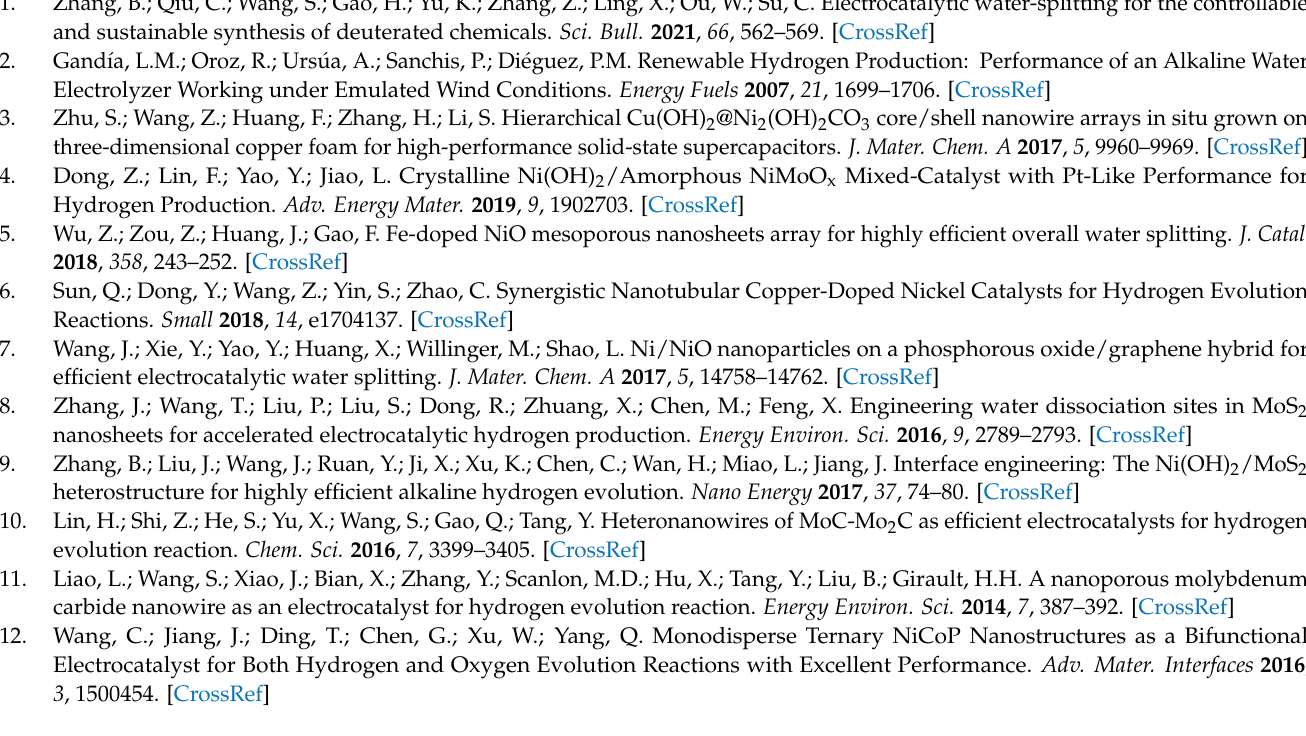
and the long-term stability measurements of Ni-Ni 3 C/NC-400, Ni-Ni 3 C/NC-450, Ni-Ni 3 C/NC-550 and Ni-Ni 3 C/NC-650 at 25 mA cm − 1 constant current density. Figure S13: (a, b) SEM micrograph, (c, d) TEM micrograph of Ni-Ni 3 C/NC-500 after a 100 h HER measurement. Figure S14: XPS spectra of Ni-Ni 3 C/NC-500 after a 10 h long-term HER test. Figure S15: Thermogravimetric analysis (TGA) curve of Ni-Ni 3 C/NC-500. Figure S16: The equipment picture of alkaline OWS test in 1 M KOH solution. Figure S17: The volumes of H 2 and O 2 as a function of time in the electrocatalytic overall water splitting. Figure S18: Side (top) and top (bottom) view of three surfaces, including Ni (111), Ni 3 C (113) and Ni (111)/Ni 3 C (113). Figure S19: The equipment picture of in-situ electrochem- ical Raman spectrum. Table S1: N 2 adsorption-desorption isotherms and pore-size distribution curves of the Ni-Ni 3 C/NC-450, Ni-Ni 3 C/NC-500 and Ni-Ni 3 C/NC-550. Table S2: Comparison of catalytic parameters of Ni-Ni 3 C/NC-500 and other Ni-based HER composite-catalysts in alkaline media. Table S3: Comparison of catalytic parameters of Ni-Ni 3 C/NC-500 and other Ni-based OER composite-catalysts in alkaline media.